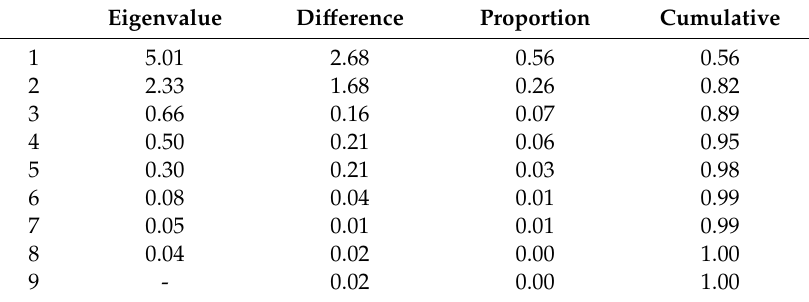
Table 1. Eigenvalue of the principal component analysis of temperature, salinity, and dissolved oxygen (DO) of water sampled by CTD from above, at, and below pycnocline at both the North and South Stations.